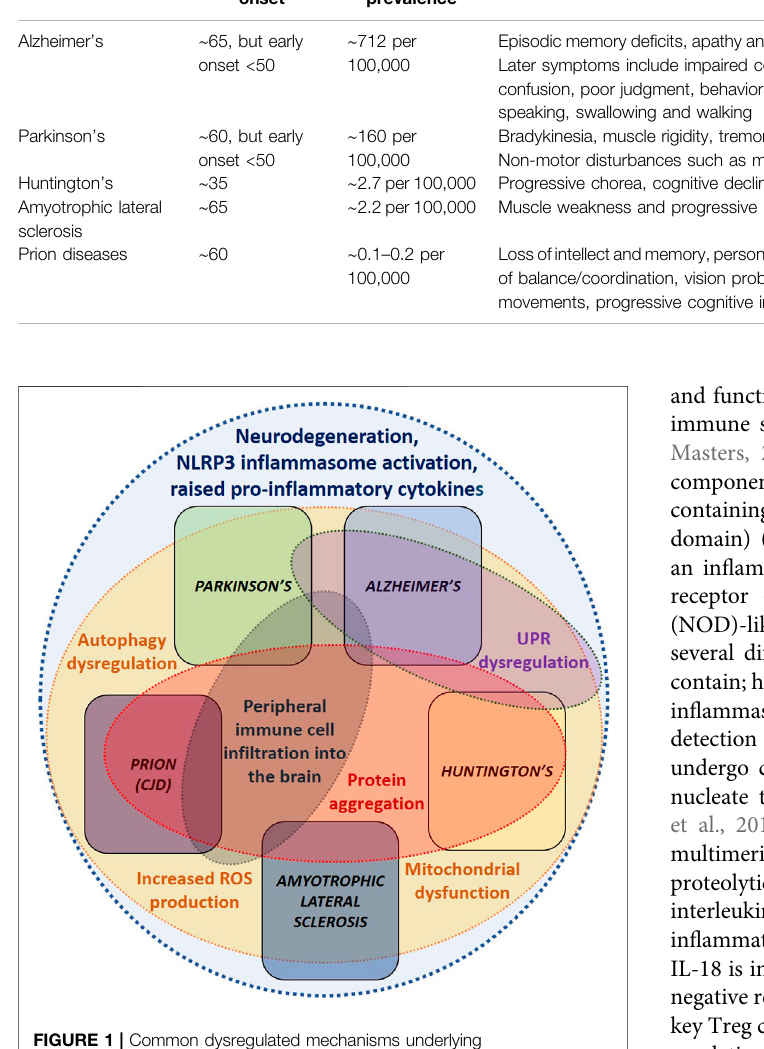
FIGURE 1 | Common dysregulated mechanisms underlying neurodegenerative diseases. Demonstrating the similarities between the dysregulatedmechanismsunderlyingeachoftheneurodegenerativediseases covered in this review. These overlapping disease mechanisms suggest that similar therapeutics could be utilised to treat several of these